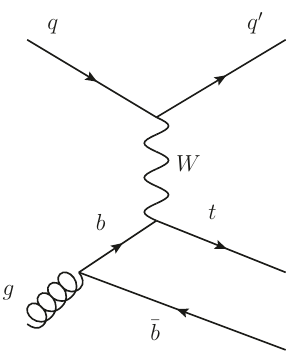
Figure 1. Leading-order Feynman diagram for t -channel production of single top quarks in pp collisions. In the depicted four-(cid:13)avour scheme (2 gluon splitting into a bb